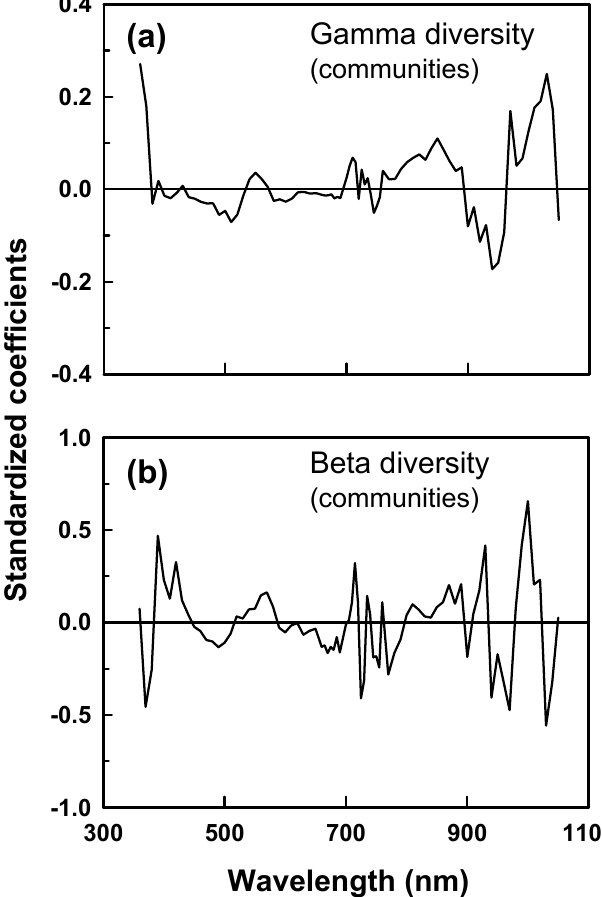
Figure 7. Standardized weightings of regression coefficients from PLSR relationships between two indices of species diversity and spatial heterogeneity in brightness normalized values of canopy reflectance: ( a ) γ diversity and ( b ) unit interval of β diversity ( β 0-1 ) of combinations of 7 m diameter patches of grassland vegetation (communities; n = 47).